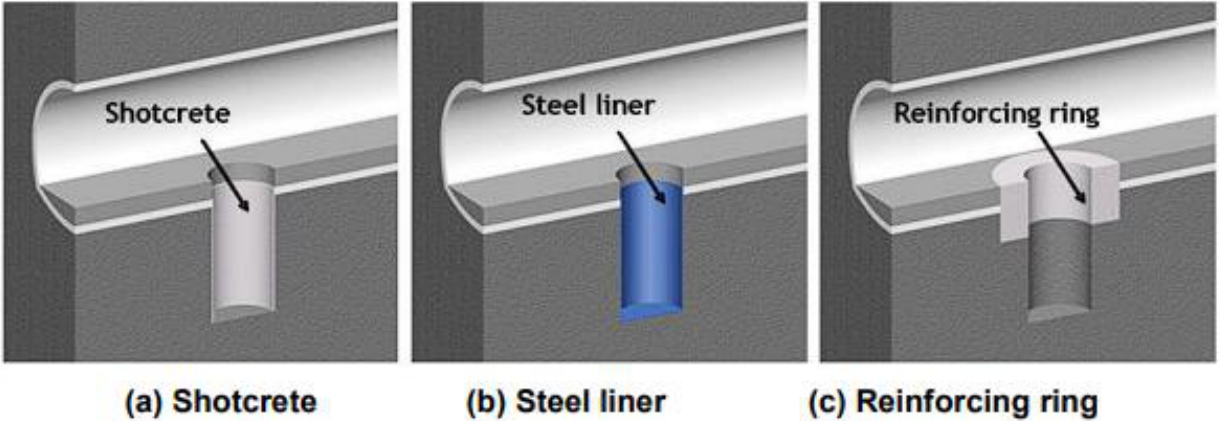
Figure 15. Borehole reinforcing options in Japanese disposal facility development reports [58].